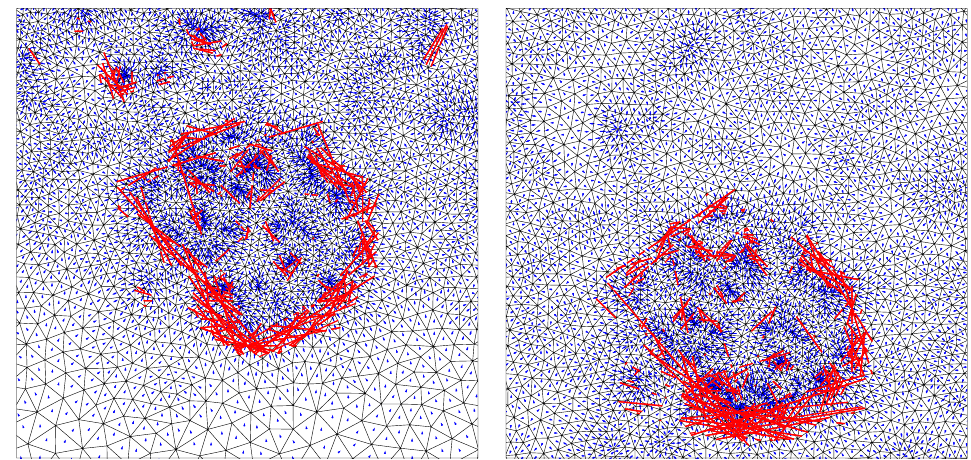
Figure 33 . The same as figure 27, but for the point data in figure 32. Here we scanned on a coarser 40 × 40 grid after applying 7 Lloyd steps. The red lines have rescaled flux values (7.3) in the top 4 percentile (with γ = 1